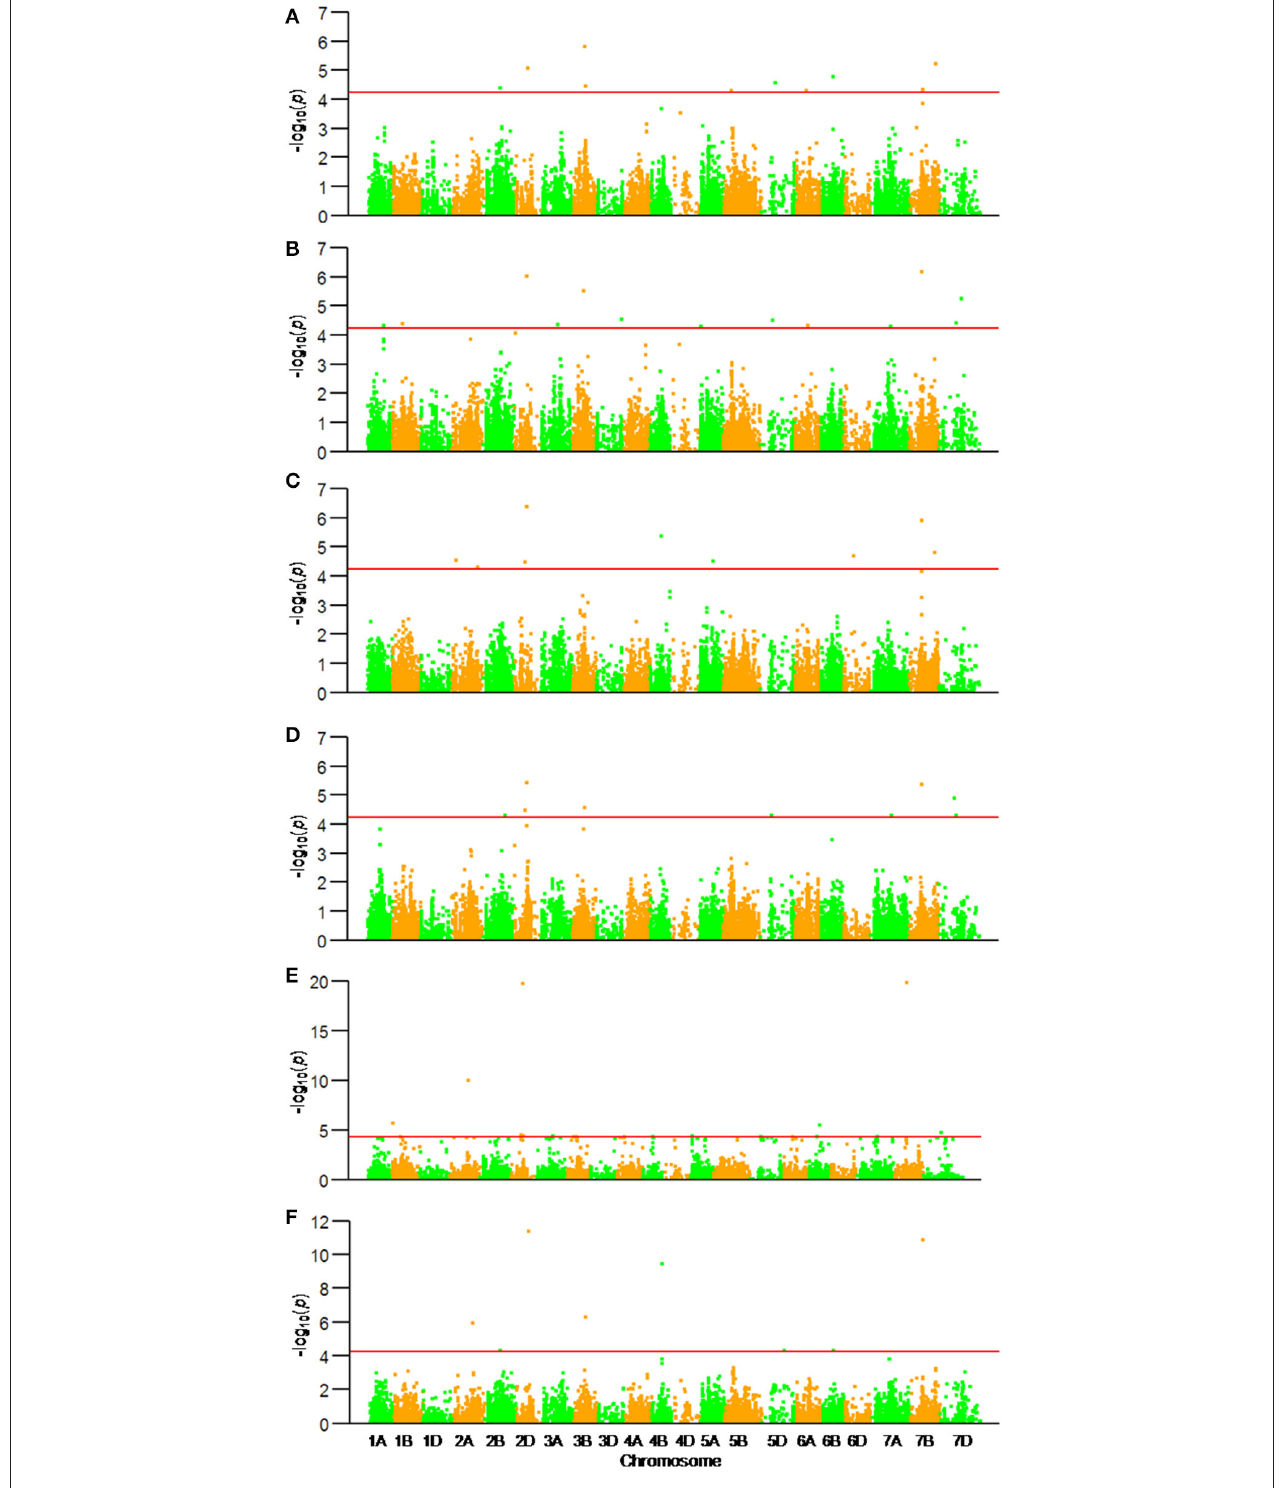
FIGURE 2 | Associations of kernel number per spike with 20,037 genome-wide SNP markers illustrated as dotplots of compressed MLM at P < 4.99 × 10 − 5 . Red dotted line indicates the threshold value for declaring a significant association. (A) 14JZ; (B) 14YZ; (C) 15JZ; (D) 15YZ; (E) 16XX; (F) BLUP.